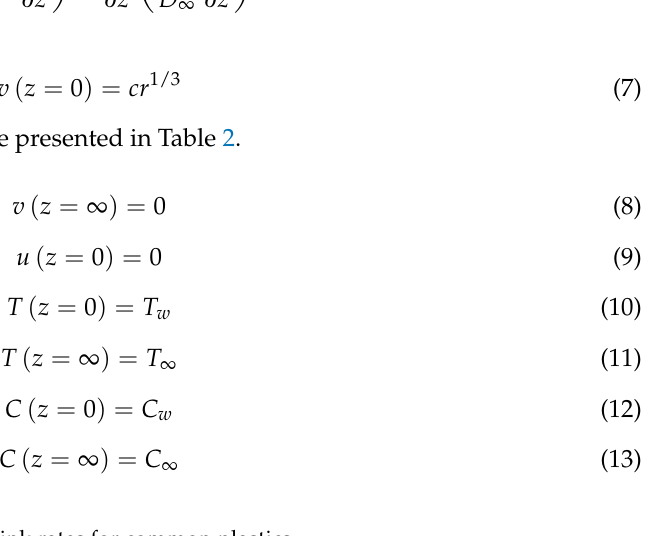
Table 2. Shrink rates for common